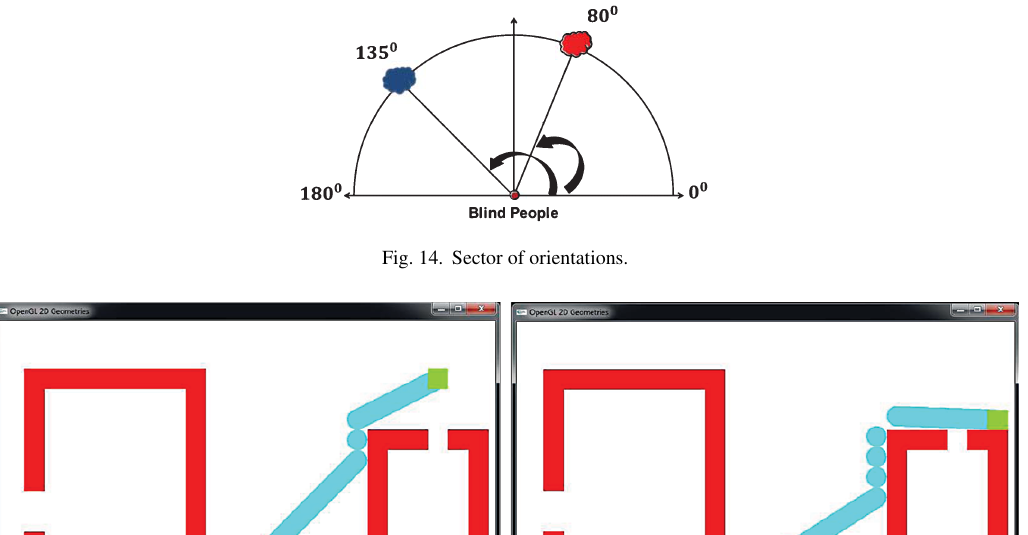
Fig. 14. Sector of orientations.